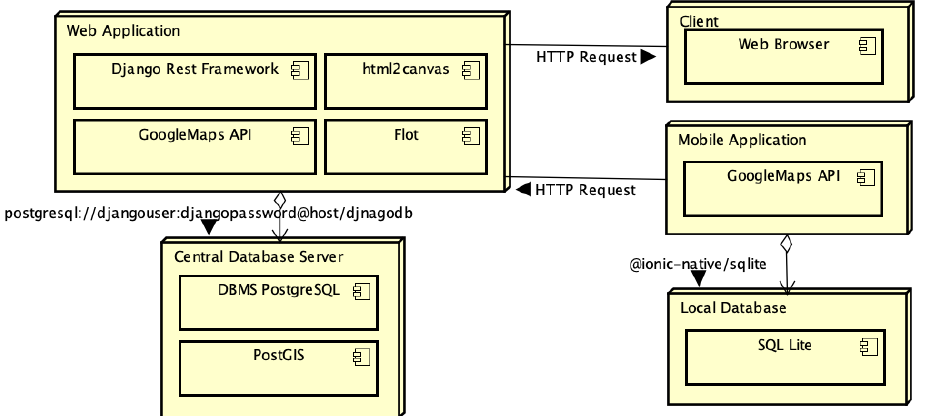
Figure 2. Implementation design of the NutriOdonto environment. Source: Author’s own creation.